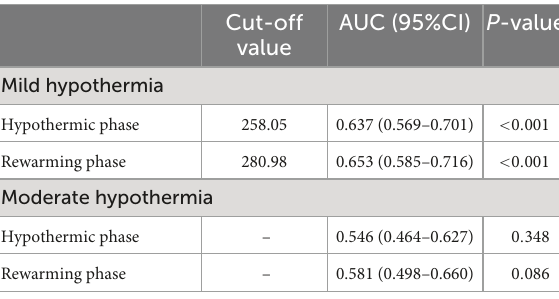
TABLE 3 Receiver operating characteristic (ROC) curve of nadir DO 2 i in hypothermic and rewarming phases for postoperative